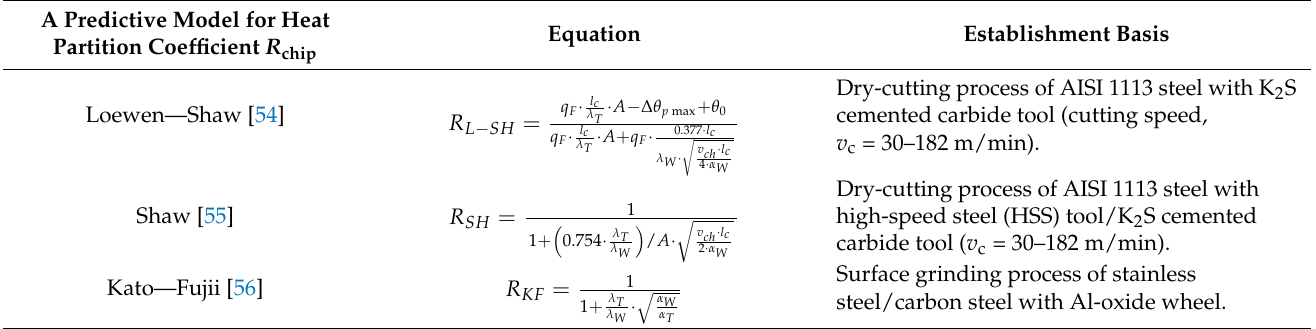
Table 5. Predictive models based on physics and experiment for heat partition coefficient R chip